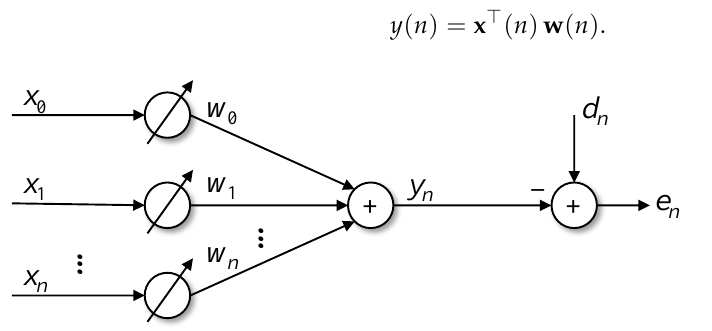
Figure 2. Weight diagram of the LMS algorithm